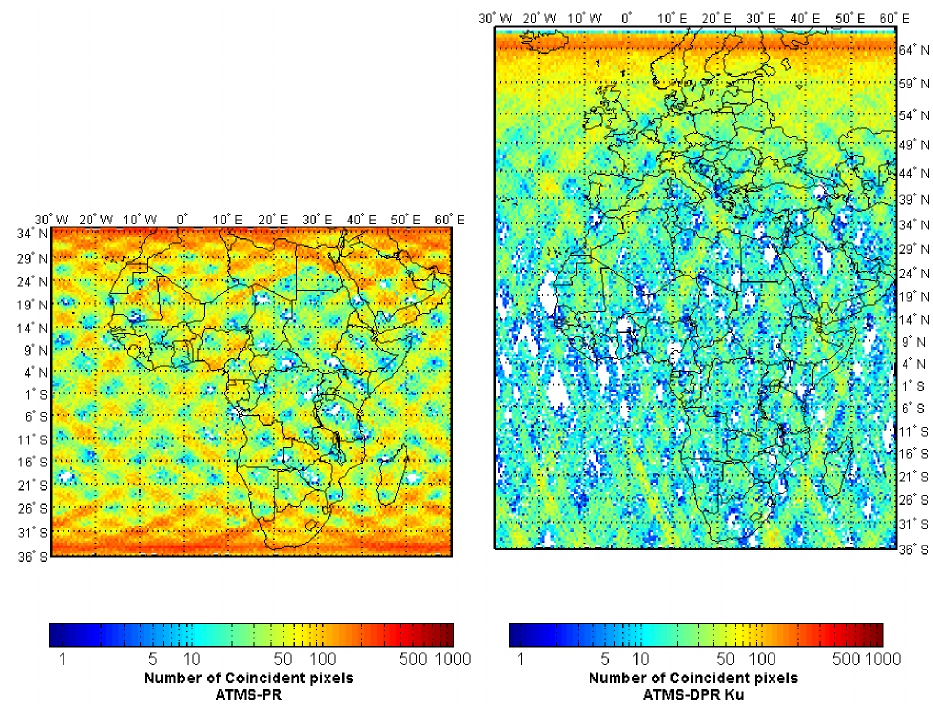
Figure 3. Number of co-located pixels from TRMM-PR and the Suomi-NPP ATMS coincident overpasses over the African area in the 24- month period 2013–2014 (left panel) and from GPM-Ku-NS and Suomi-NPP ATMS coincident overpasses over European and African areas in the 15-month period (March 2014–May 2015) (right